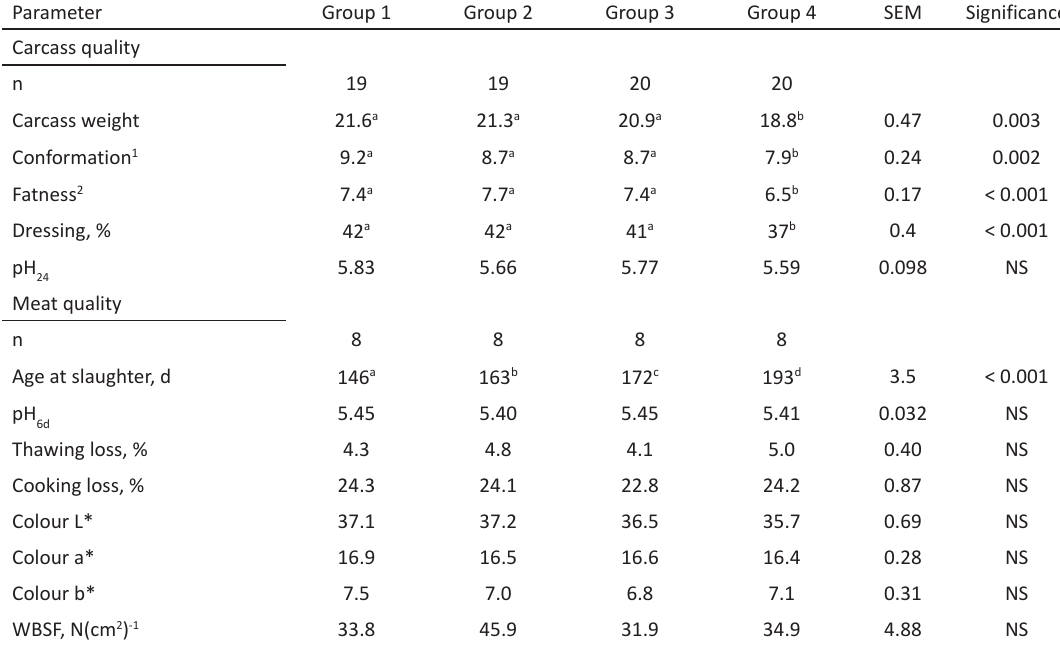
Table 4. Carcass quality and meat quality of lambs reared using four different production systems